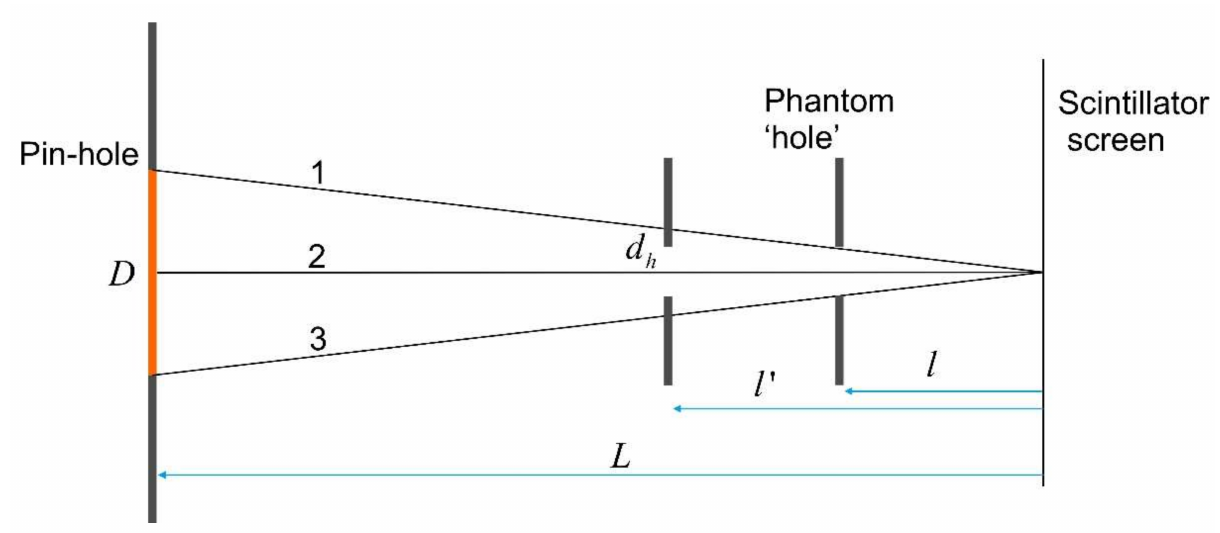
Figure 1. Illustration of the blurring effect in the pin-hole geometry (see Equation (1)). Num- bers denote three base rays of the neutron beam. When the phantom is placed at distance l from the scintillator the center point of the hole will be absolutely transparent for neutrons, because (cid:48) + I 2 + I (cid:48) I = I 1 + I 2 + I 3 = 1. At distance l (cid:48) I = I < 1, and the hole appears to be attenuative even in 3 1 I 0 I 1 + I 2 + I 3 I 0 I 1 + I 2 + I 3 its center